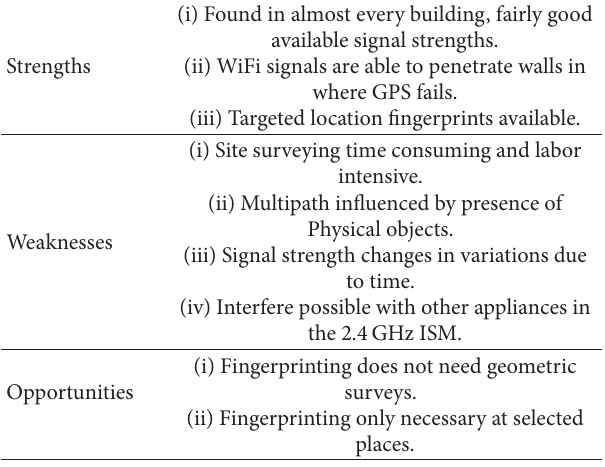
Table 2: WiFi strengths, weaknesses, and opportunities.